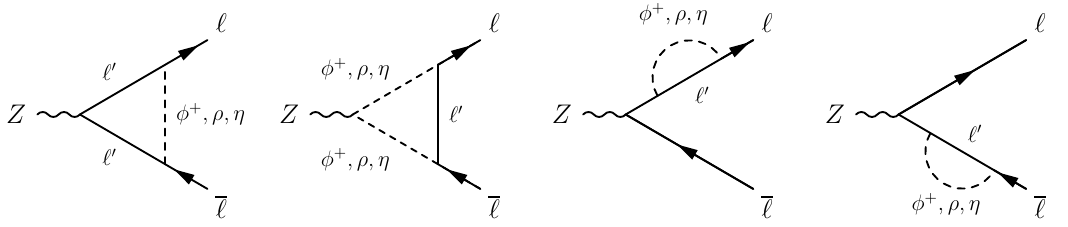
Figure 4 . Feynman diagrams of the loop corrections to Z boson leptonic